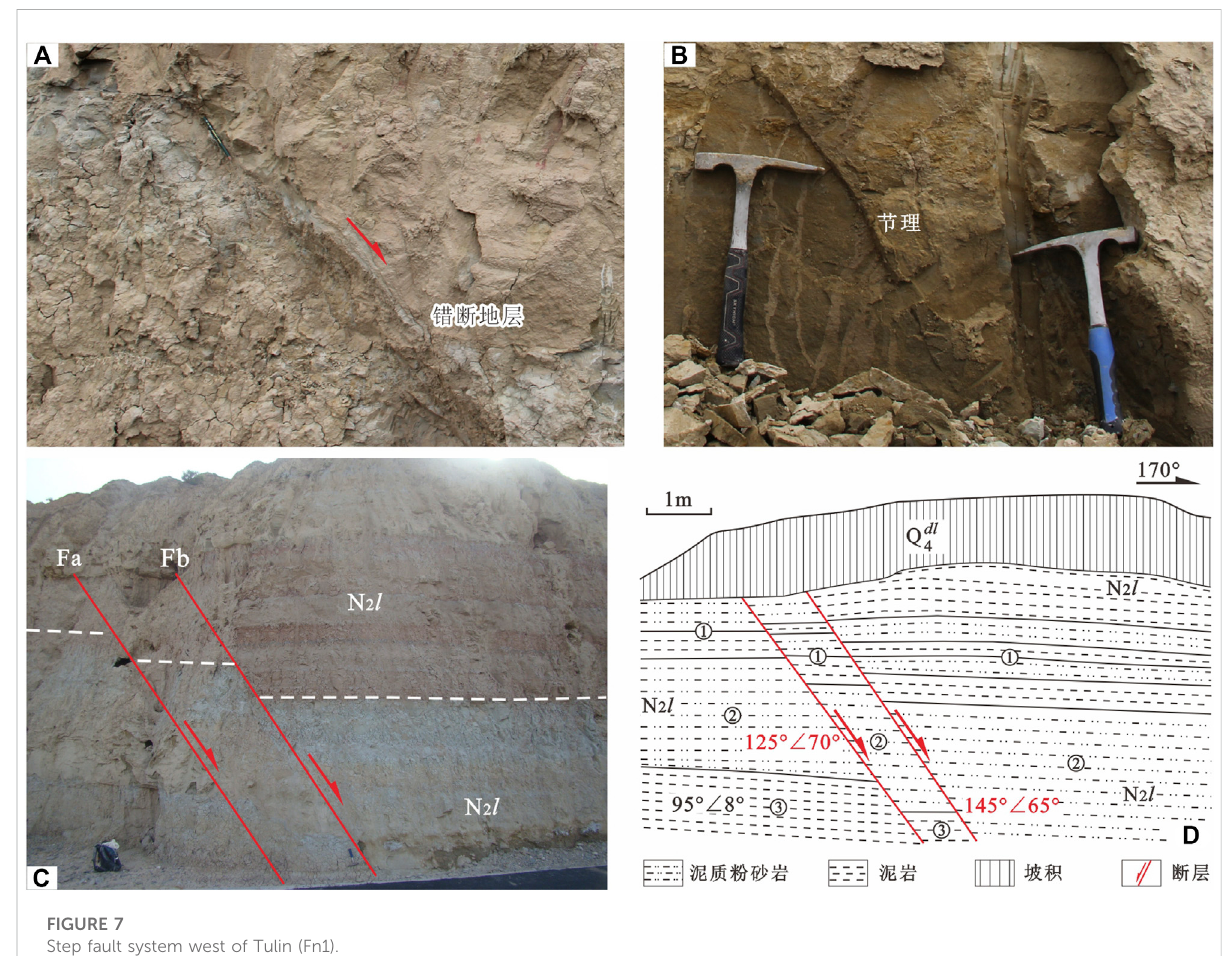
FIGURE 7 Step fault system west of Tulin